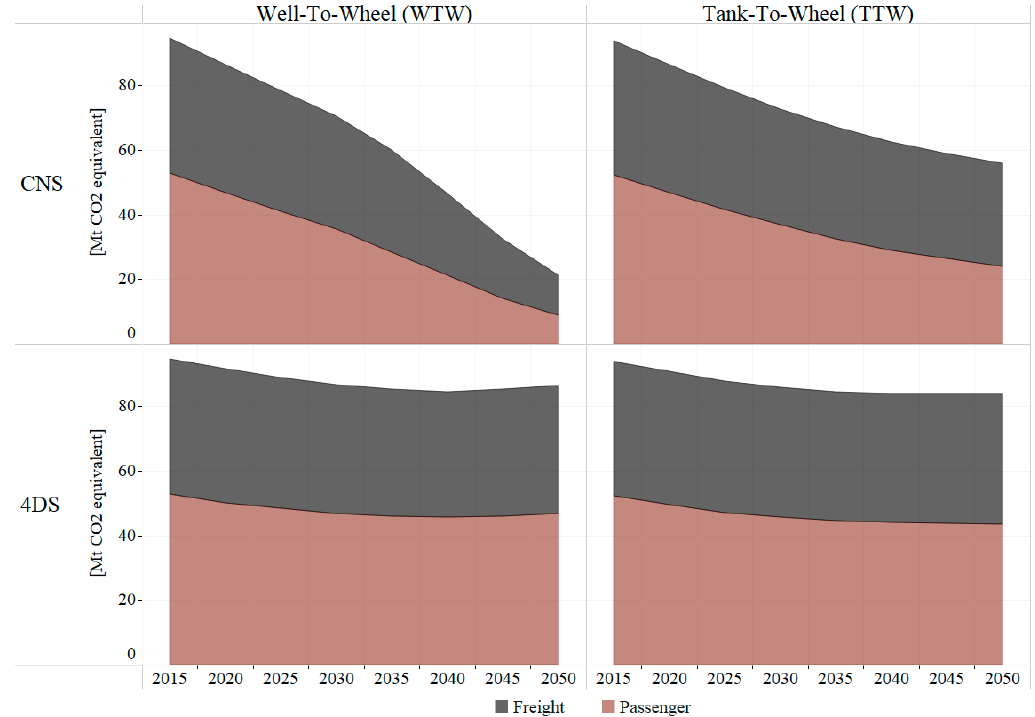
Figure 2. Well-to-wheel (WTW) and tank-to-wheel (TTW) GHG emissions in the CNS and 4DS. Results from MoMo, provided by [44], are interpolated with a five-year step resolution.